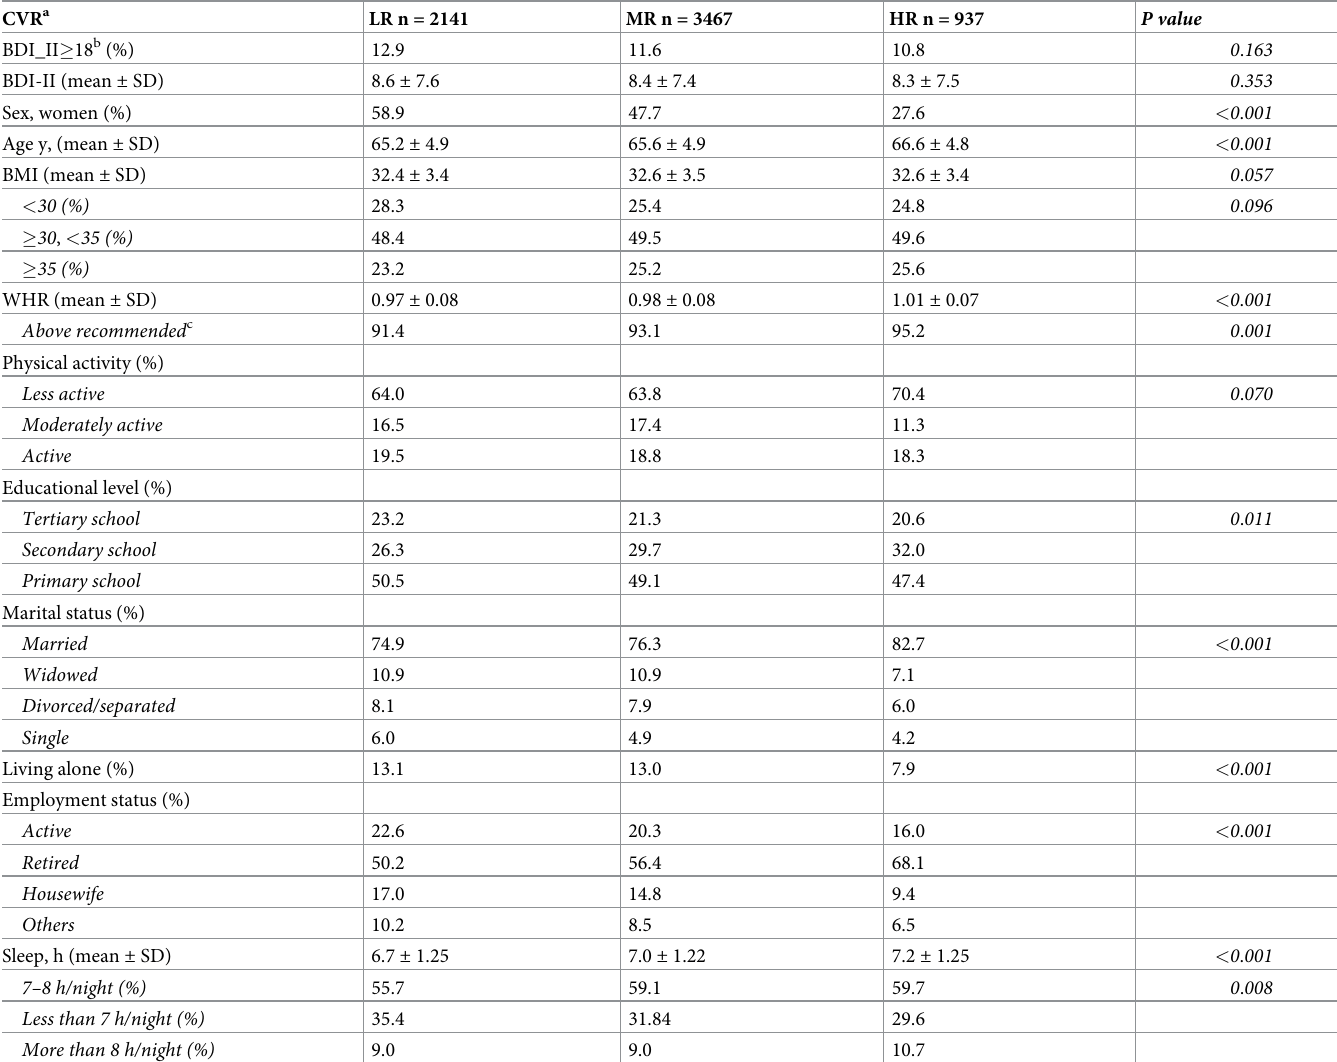
Table 1. Baseline characteristics of the study